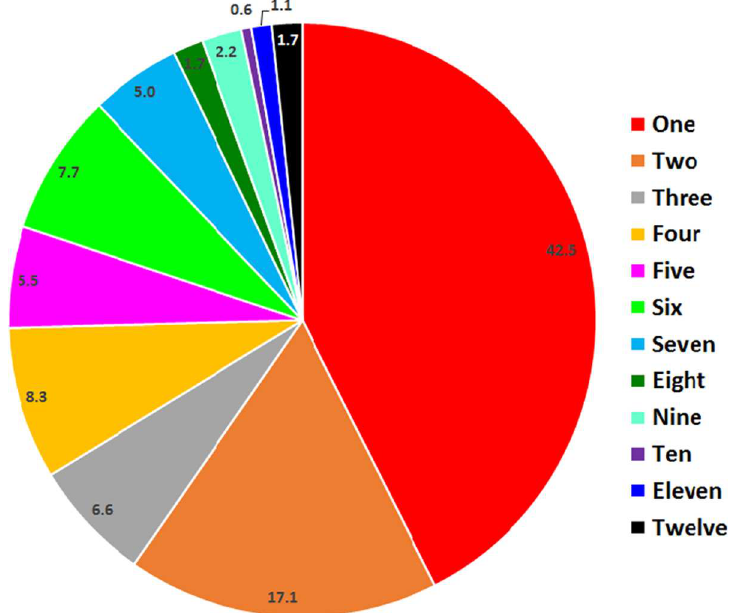
Fig 3. Number of OTUs that were unique to one mosquito species or shared between two or more mosquito species. n = 181.